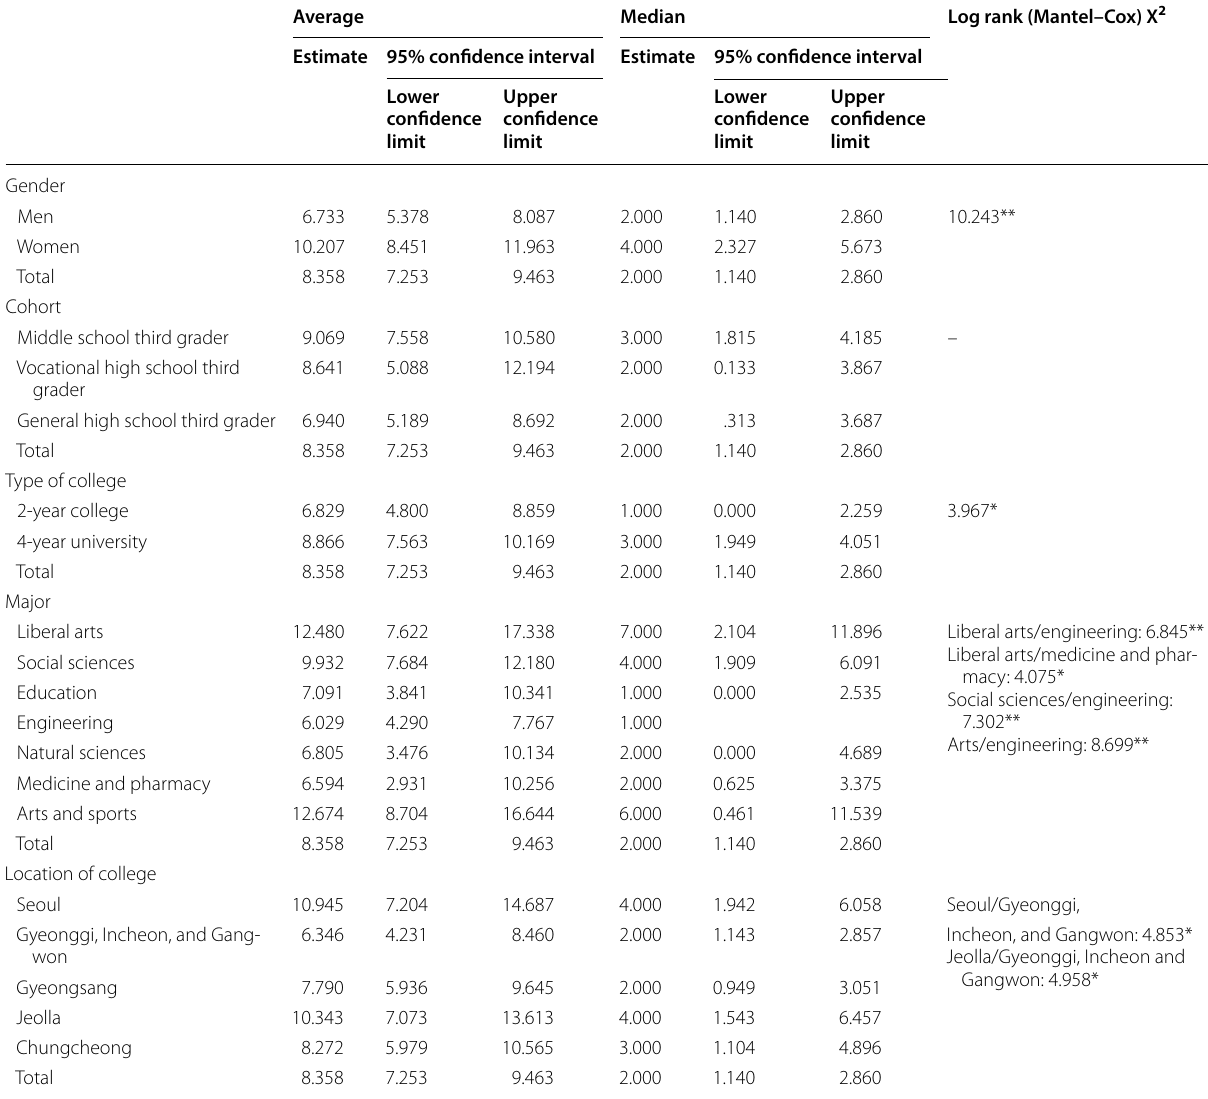
Table 6 Estimated average and median unemployment exit duration based on the individual and college characteristics (Kaplan–Meier